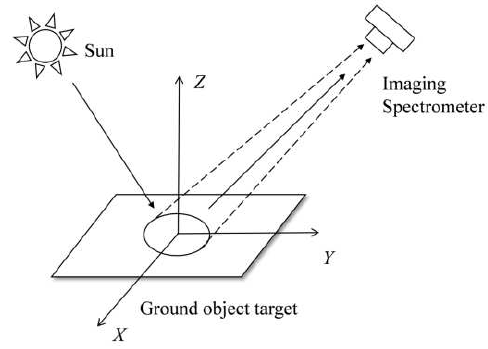
Figure 6. Imaging spectrometer.